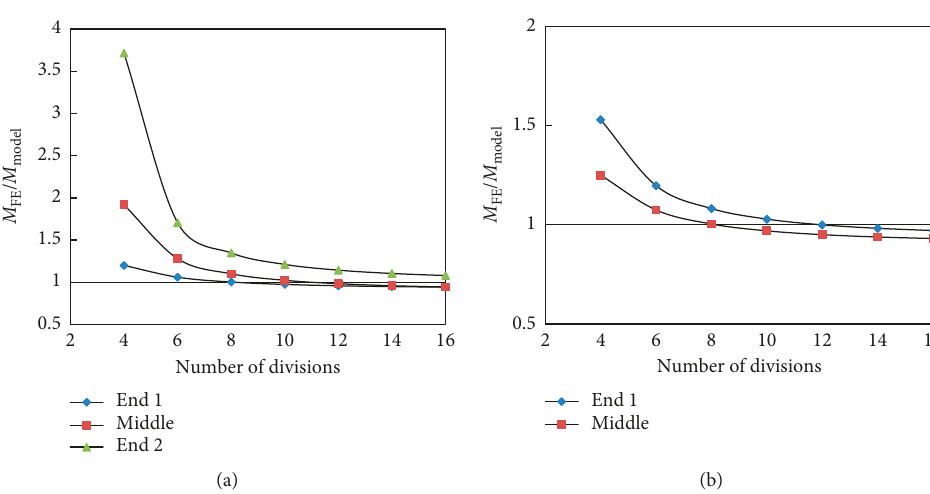
Figure 10: Sensitive analysis for number of division effect on internal forces of a circular arch. (a) Internal forces due to rotation at End 1 and (b) internal forces due to horizontal displacement at End